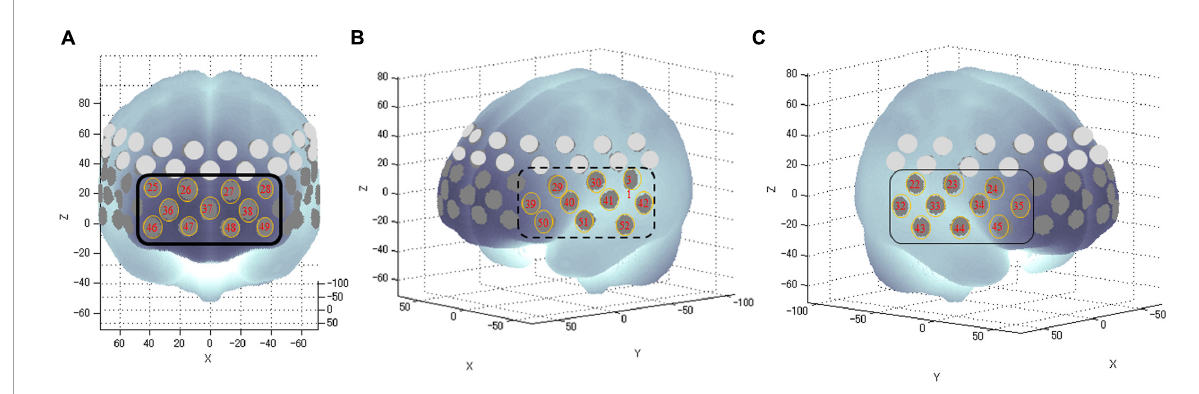
FIGURE2 Anatomical areas of the brain measured by fNIRS. The numbers in tangerine-colored circles represent the channels of measurement in the anatomical area (A) : The frontopolar area (channel #25–28, 36–38, and 46–49) corresponding to the superior and middle frontal gyri; (B) : Left frontotemporal areas (channel #29–31, 39–42, and 50–52) corresponding to the inferior and middle frontal gyri; and (C) : Right frontotemporal areas (channel #22–24, 32–35, and 43–45) corresponding to the anterior portion of the superior and middle temporal gyri.